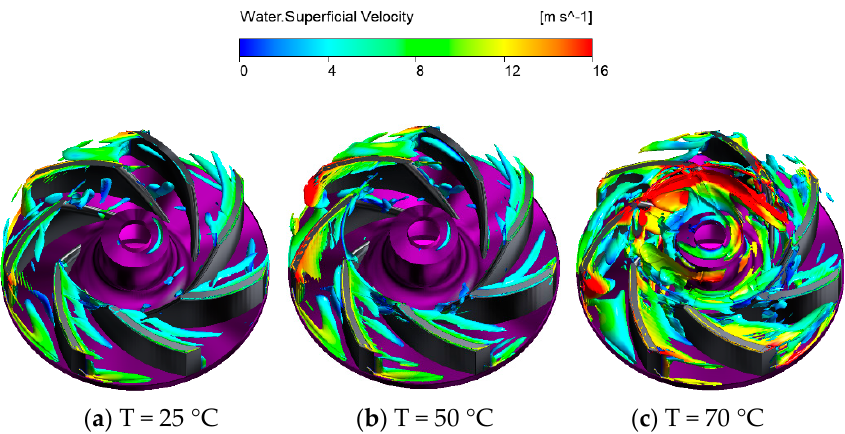
Figure 15. Vortex distribution with different temperatures based on the same cavitation.